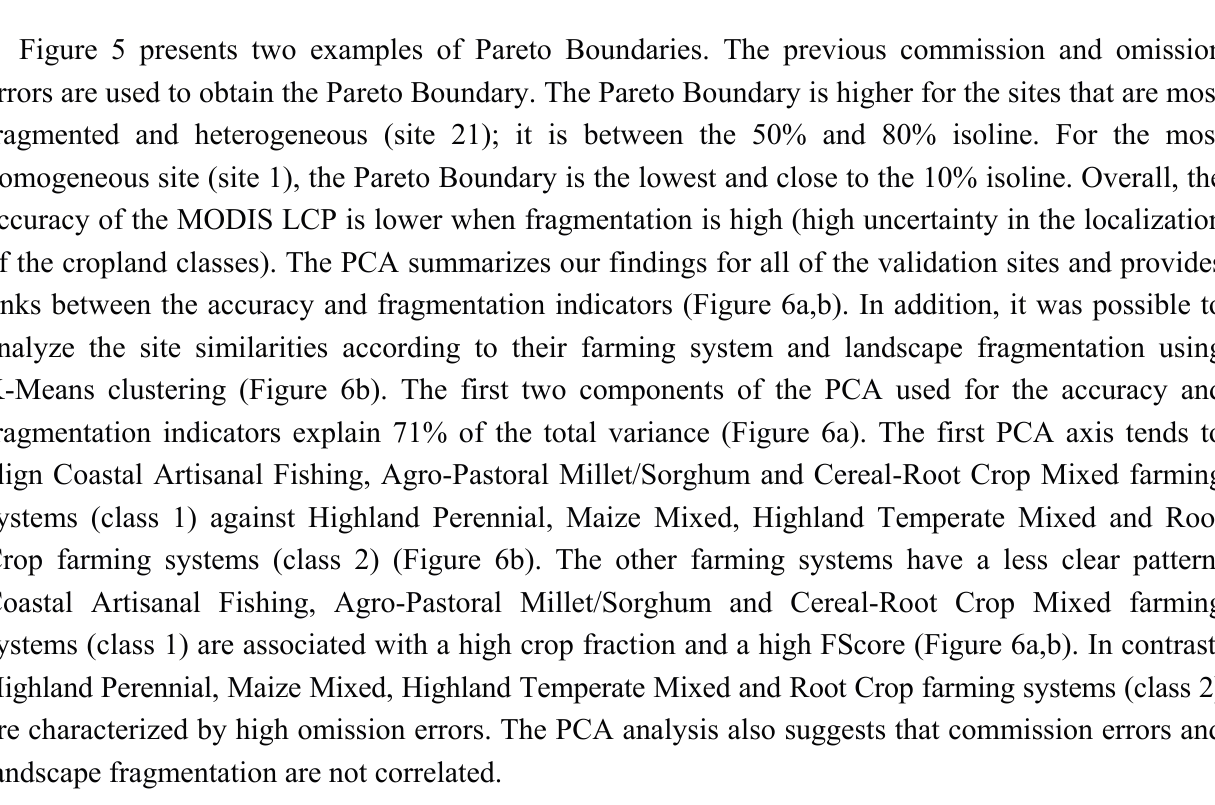
Figure 6. Normalized principal components analysis (PCA) performed on the six indicators of agricultural landscape fragmentation and the three accuracy indicators. ( a ) Correlation circle of variables for the first two PCA components; ( b ) PCA factorial map presenting 55 validation sites grouped into two classes as obtained from the K-Means